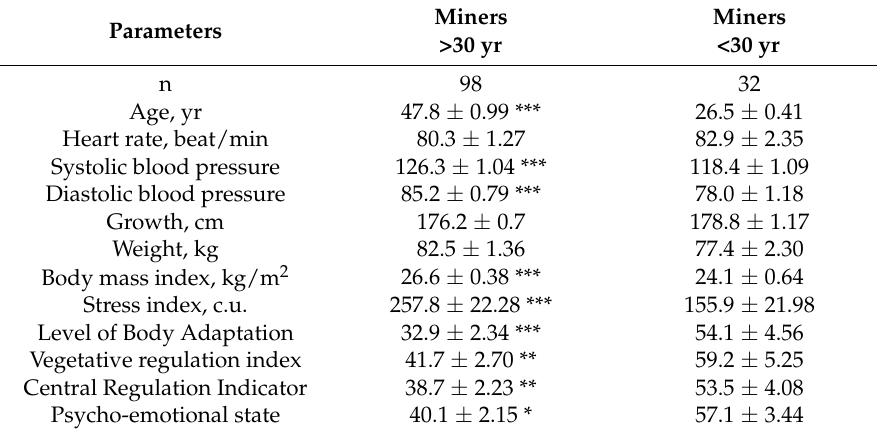
Table 3. Physiological state of the miners.